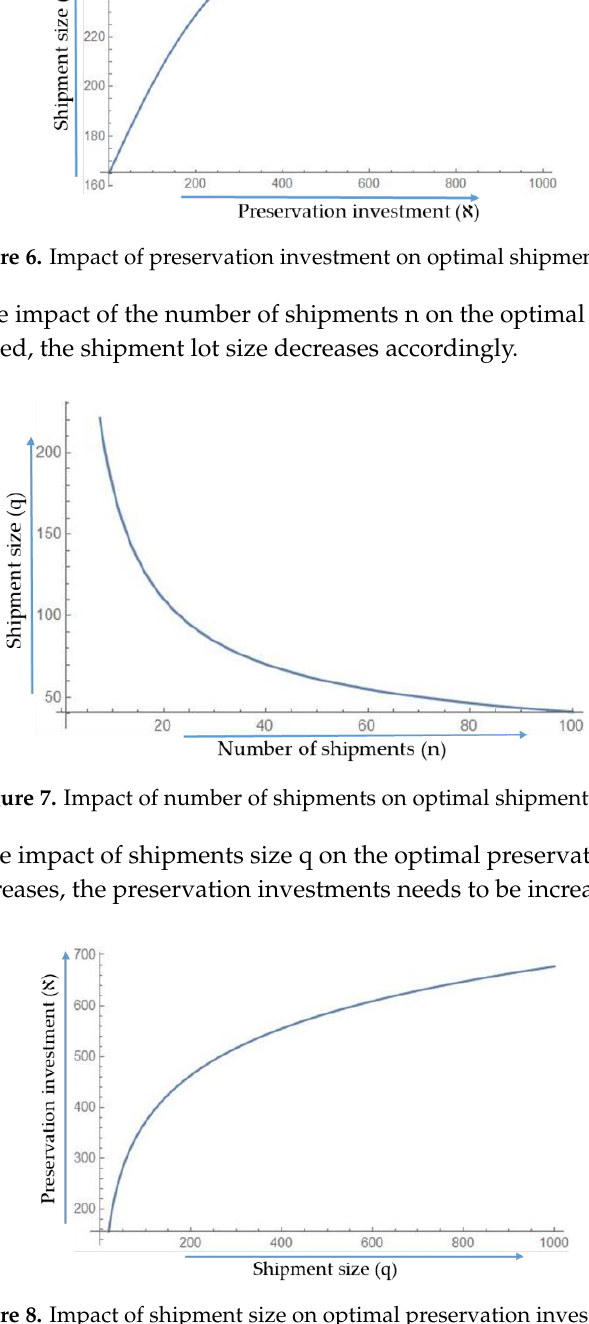
Figure 8. Impact of shipment size on optimal preservation investment.